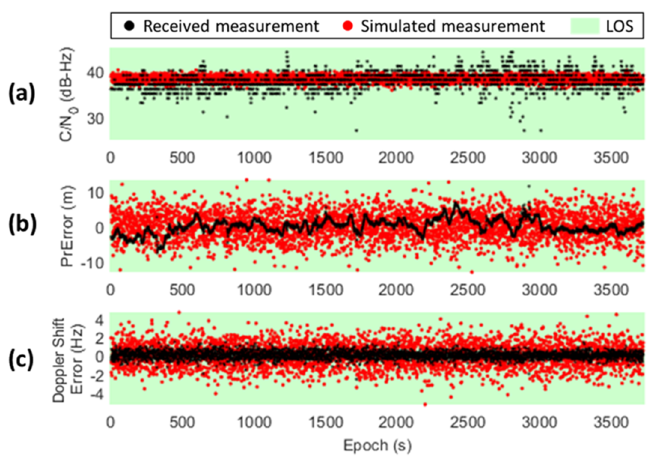
Figure 11. The comparison of the simulated and actual received GNSS measurements from B4 satellite during the one-hour static experiment, including: ( a ) C / N 0 ; ( b ) pseudorange error; ( c ) single- differenced Doppler shift error. The black marker and red marker denote the real and simulated measurement, respectively. The green background denotes the measurement type as LOS during the